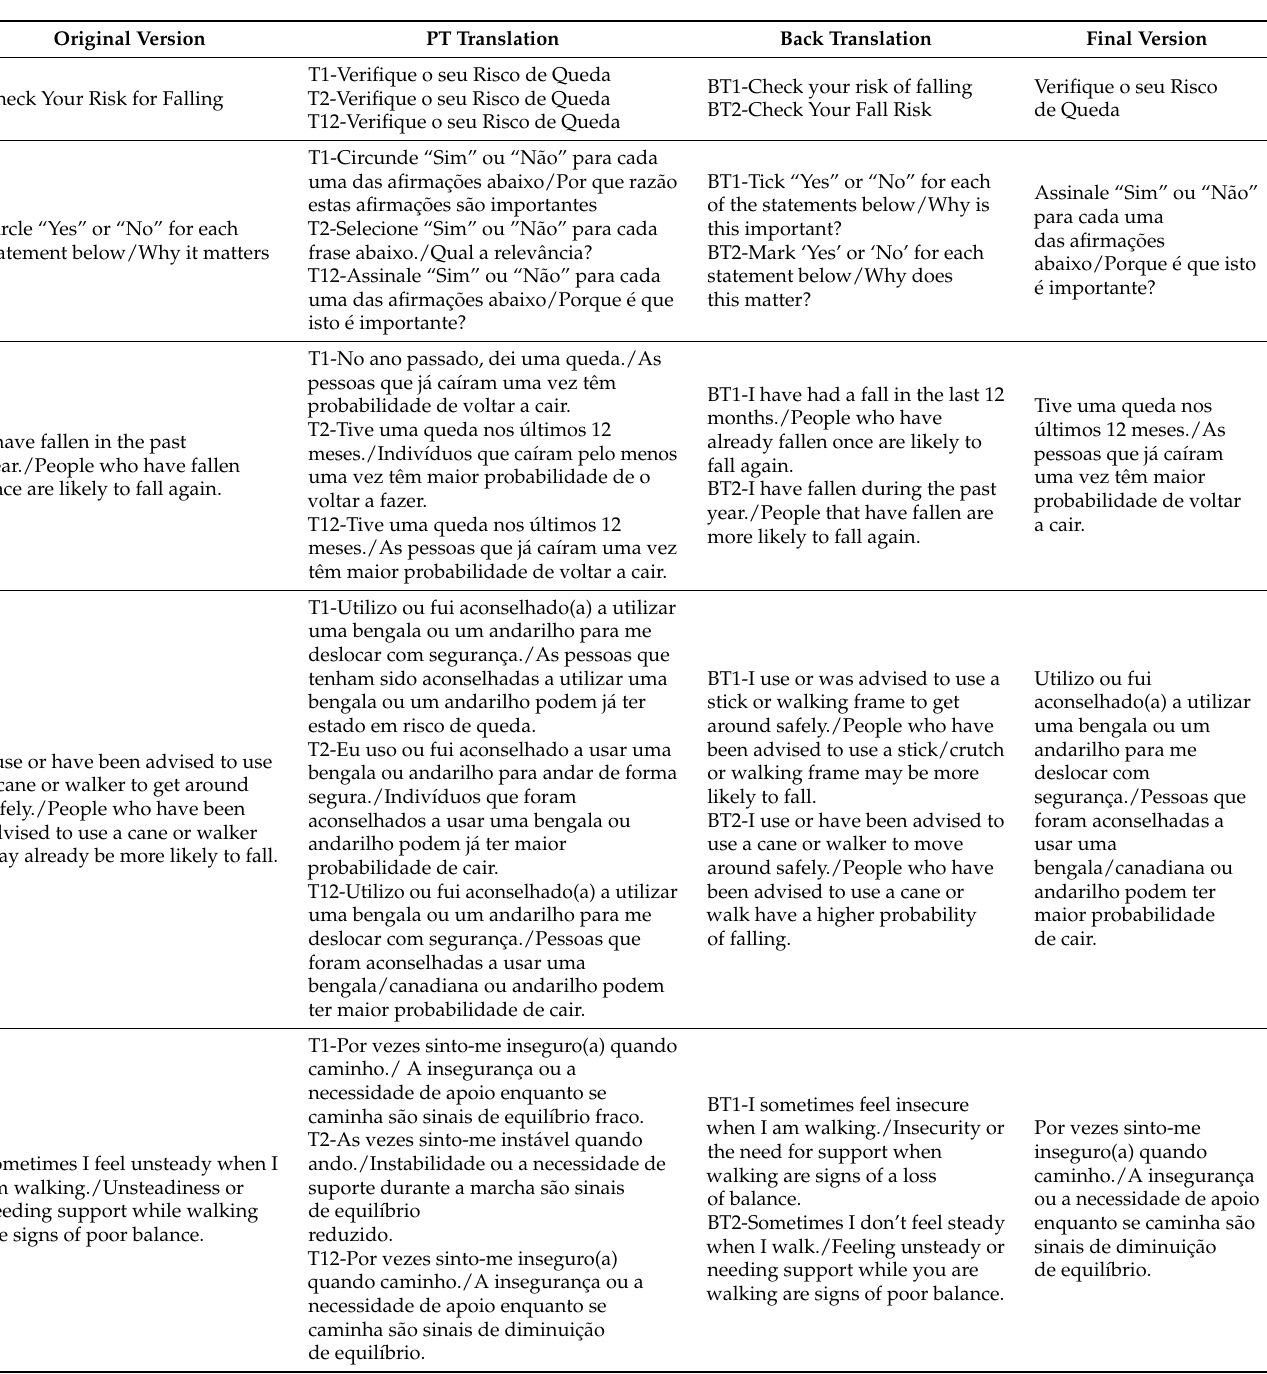
Table 1. Semantic equivalence results. T—Translation; BT—Back Translation. T12 refers to the consensus version of the translation between T1 and